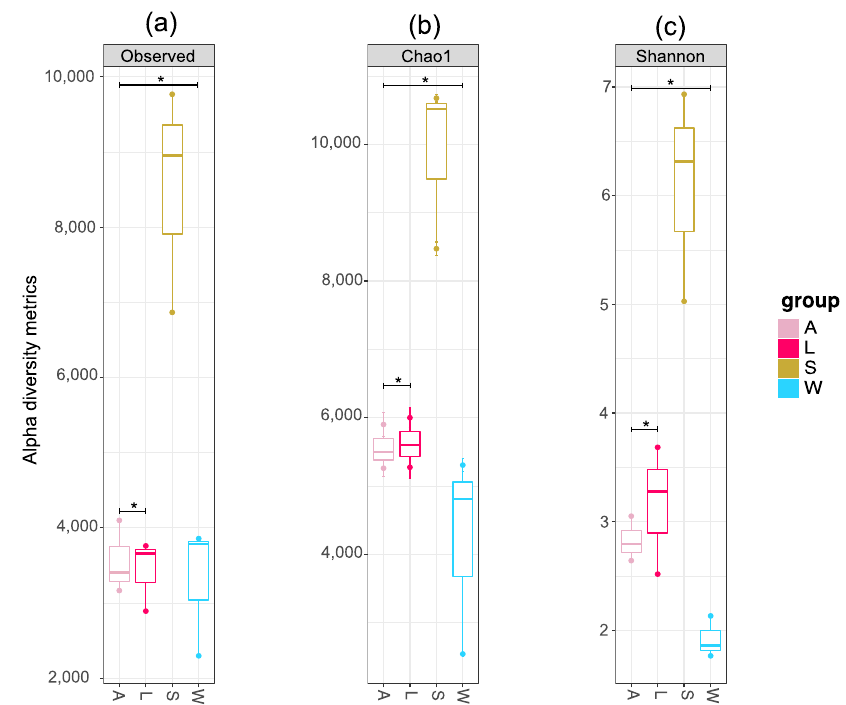
Figure 3. Boxplots of the alpha diversity metrics of the prokaryotic microbiota found in different life stages of the marine sponge P. cyanorosea and the ambient seawater and sediment: ( a ) Number of operational taxonomic units (OTUs); ( b ) Chao1 species estimator; ( c ) Shannon index. * p < 0.05 (all samples—ANOVA test and post hoc Tukey’s test; pairwise comparisons— t -test). A: adults; L: larvae; W: seawater; S: sediment.